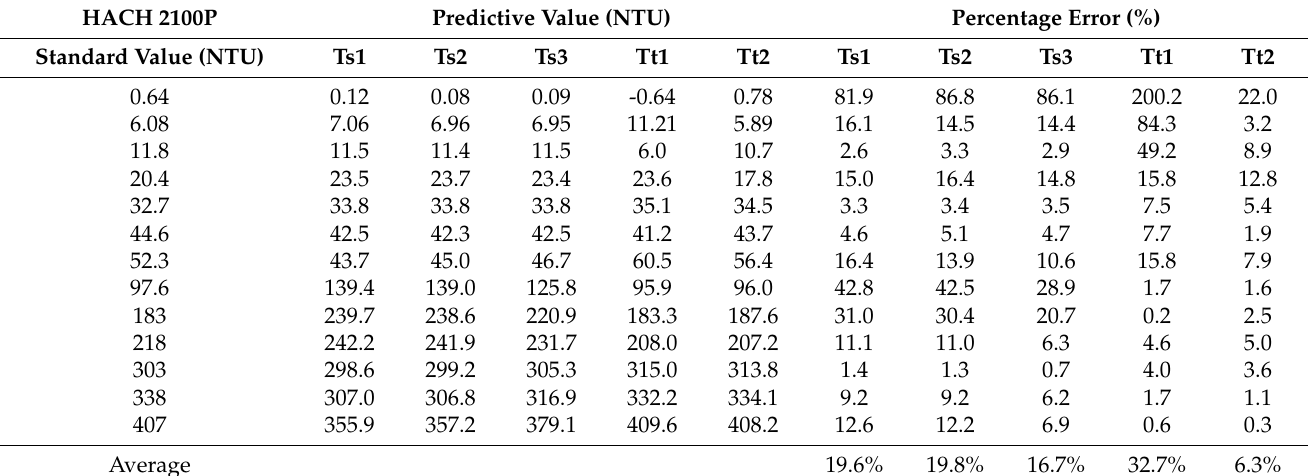
Table 6. Estimate results for concentrations of standard turbidity solutions